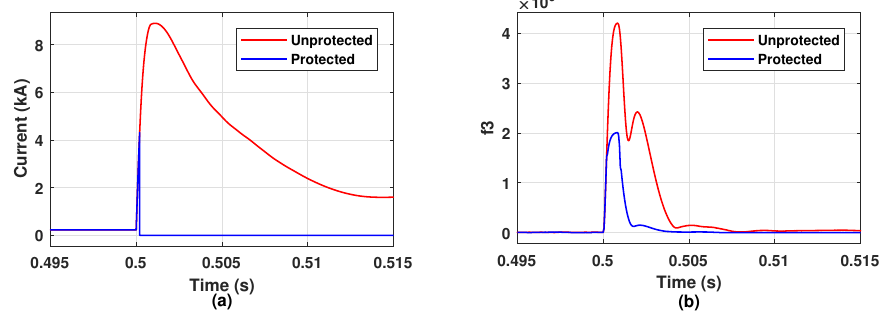
Figure 10. Interrupted and un-interrupted fault current comparison for a fault at F 1 having a resistance of 1 m Ω , ( a ) actual current and ( b ) feature f 3